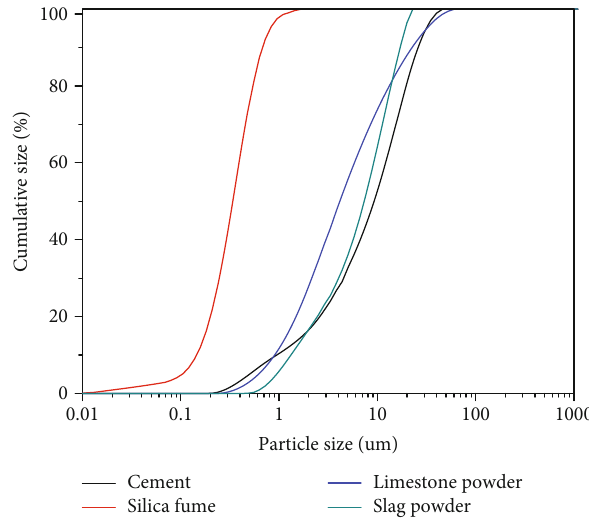
Figure 1: Particle size distributions of OPC, SF, LP, and the maximum packing density of a material mixed with par- ticles of the same size in multielement solid particles per unit volume. The compaction index re fl ects the packing degrees dominated by particles of di ff erent sizes, which are the eigen- values of di ff erent packing patterns of multiple constituents. In a binary system, solid particles are packed in two patterns (Figure 2): (a) relaxation e ff ect and (b) wall attachment e ff ect. The former shows that small particles prevent large ones from reaching the closest packing when the system is domi- nated by large particles; the latter shows that the closest pack- ing is thwarted by the predominant small particles attached around the surface of large ones.